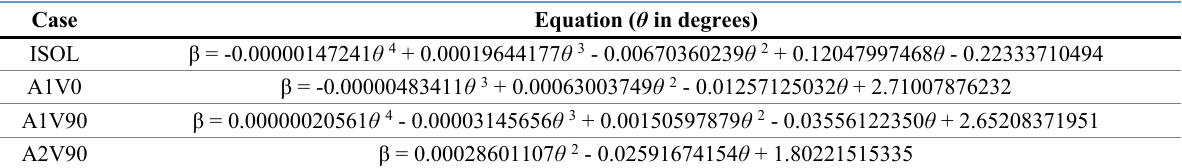
Table 6. Equations of β for displacement at the top, x-direction – limit criterion of